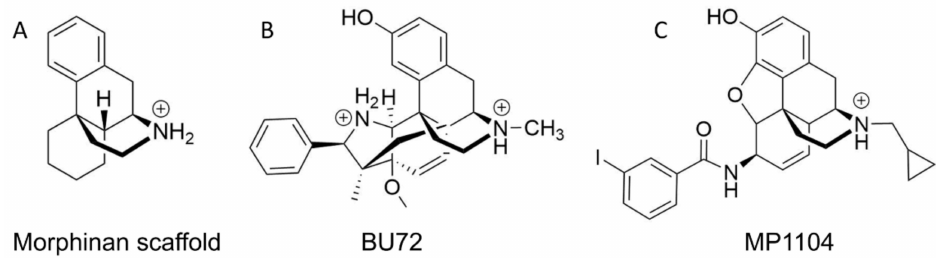
Figure 4. Chemical structures of ( A ) a morphinan scaffold and co-crystallized ligands ( B ) BU72 in MOR (PDB-ID: 5C1M) and ( C ) MP1104 in KOR (PDB-ID: 6B73) under physiological pH